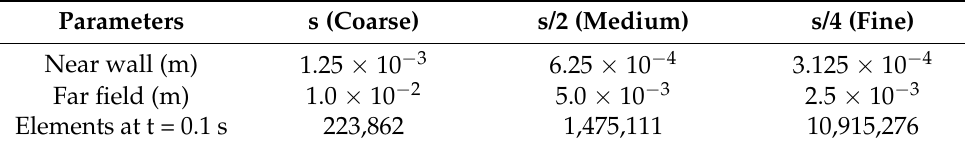
Table 3. Resolutions set-ups for the resolution-dependency